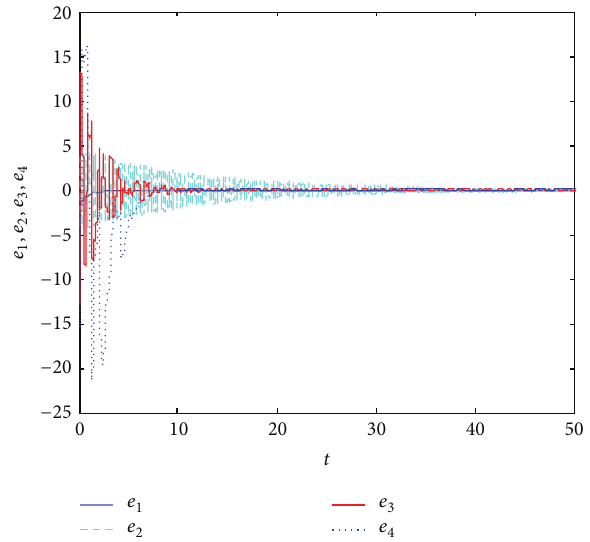
Figure 6: Time evolution of synchronization error between system (33) and system